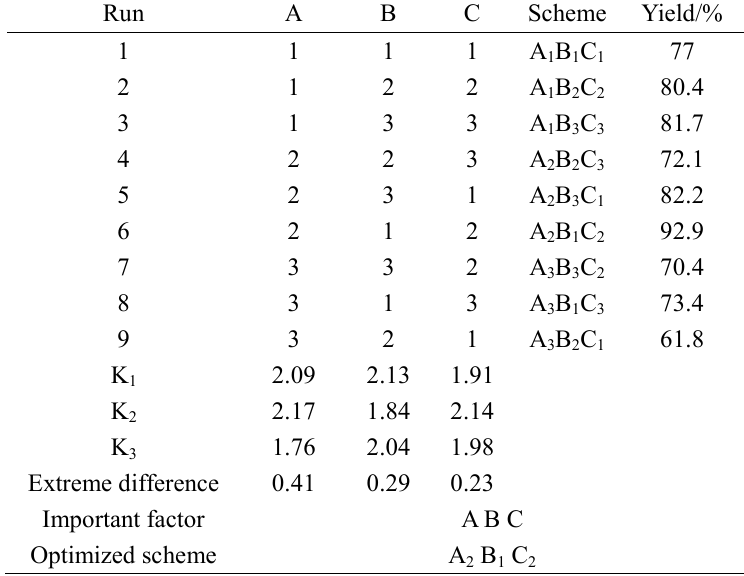
Table 2. Results of orthogonal